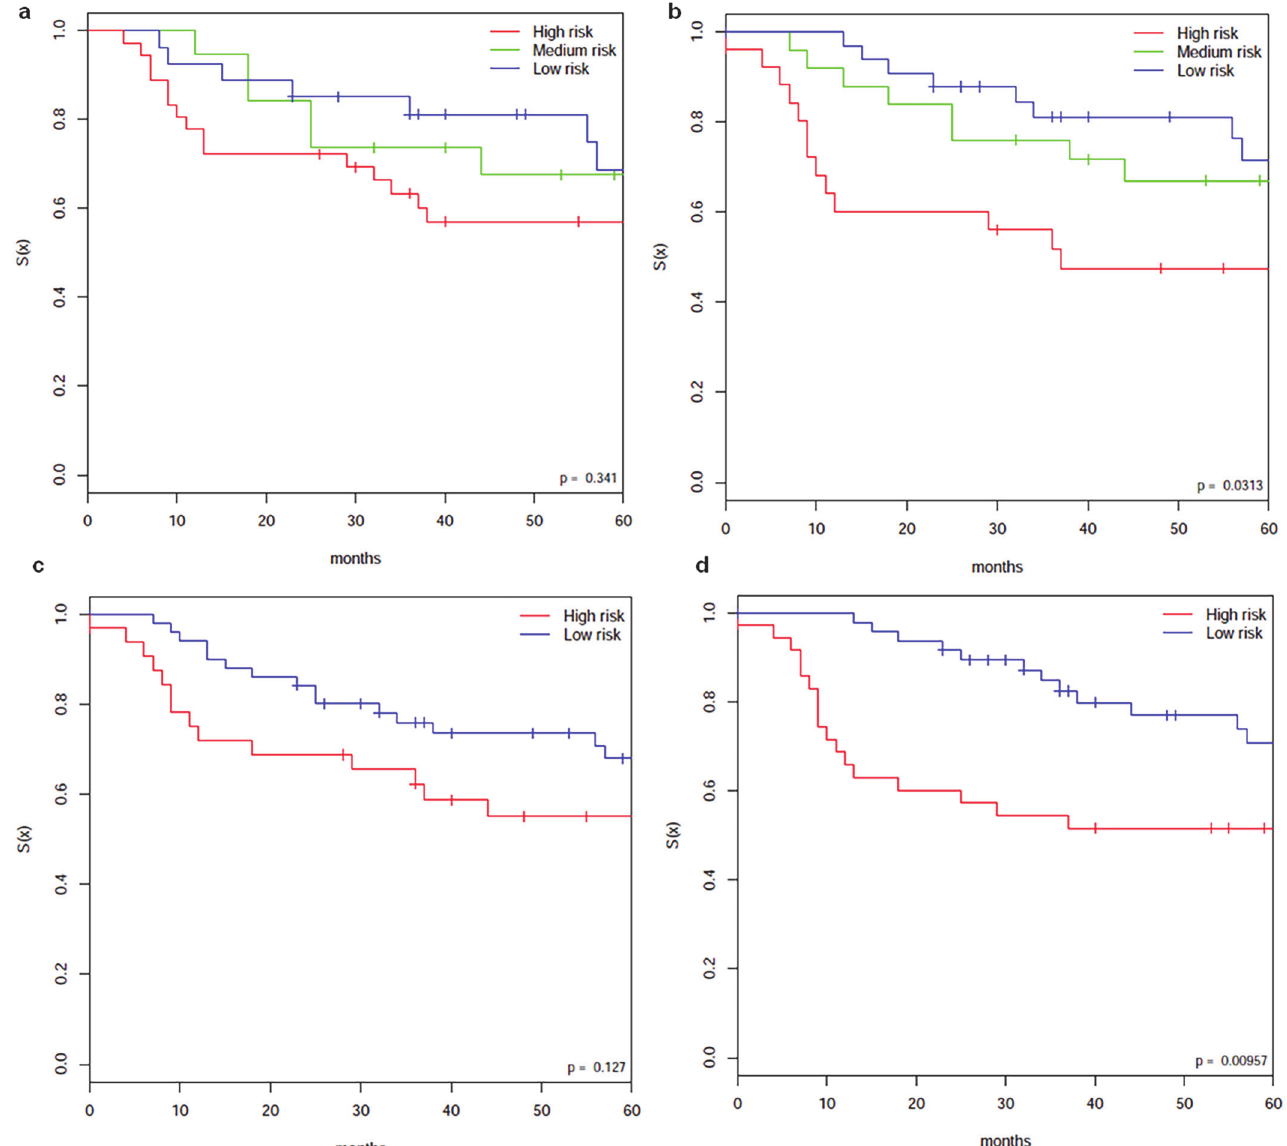
Fig 3. Comparison of the cluster of Hierarchical clustering (Hclust) versus that of MBI, and the cluster of NMF versus that of MBI. (a) and (b). Comparison of Kaplan-Meier survival plots based on the unsupervised clusters of Hierarchical clustering (Hclust) and that of MBI, when given the same gene expression matrix M (lung ADCA Canada dataset from Shedden et al. [7]. (a) Kaplan-Meier survival plot based on Hclust. (b) Kaplan-Meier survival plot based on MBI clustering (with leave-one-out-cross-validation (LOOCV) ~99% accuracy). MBI shows a better separation of the aggressive subgroup from the other two subgroups compared with the Hclust Bryant et al. [6]. The p-values are calculated by log-rank test; The LOOCV was done using PAM [18]. (c) and (d). Comparison of Kaplan-Meier survival plots based on the unsupervised clustering of NMF (c) and that of MBI (d), when given the same gene expression matrix M (lung ADCA Canada dataset from Shedden et al. [7]). When given the same gene expression testing data, the survival curves from MBI clustering shows a more significant separation than those from NMF clustering. The p-values are calculated by log-rank